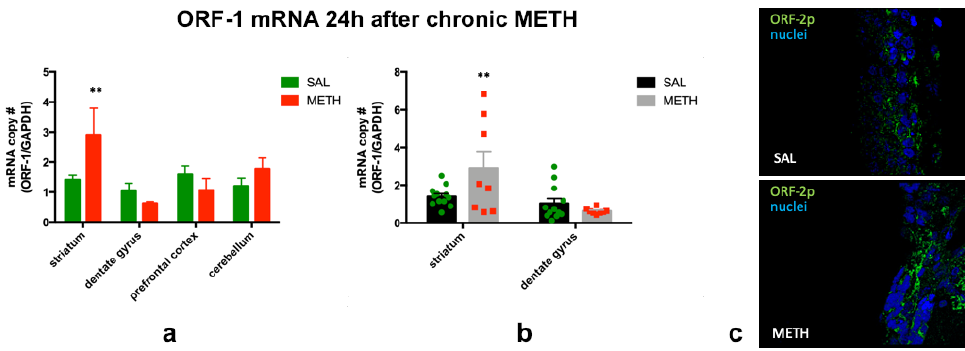
Figure 2. ( a ) The effect of chronic METH (20 mg/kg/d, for 10 d, i.p.) on ORF-1 mRNA levels in rat striatum, dentate gyrus, prefrontal cortex and cerebellum at 24 h after the last dose of METH or saline. ( b ) Individual mRNA values in the striatum and dentate gyrus. ( c ) Representative image of increased immunofluorescence for ORF-2p in the SVZ. Abbreviations: h, hour; METH, methamphetamine; SAL, saline; SVZ, subventricular zone. ** Statistical significance p < 0.01, METH vs. SAL.